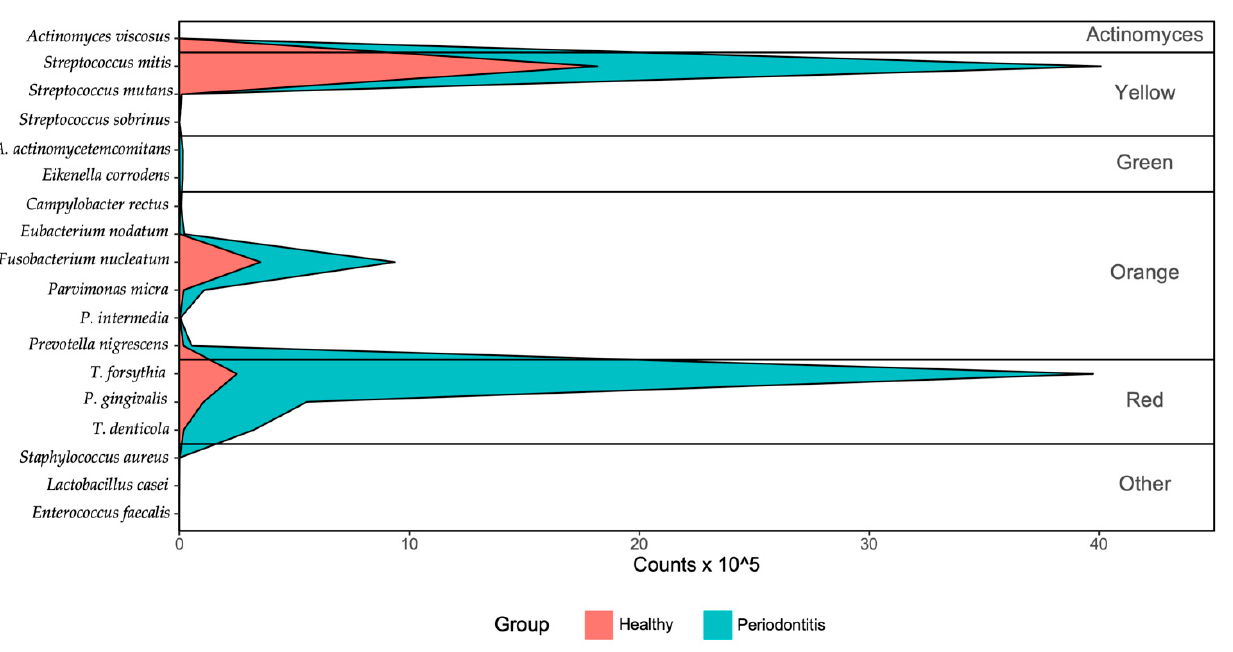
Figure 2. Mean bacterial cells in the healthy group and periodontal disease group.